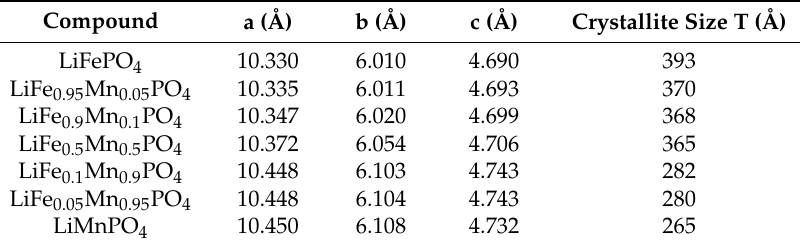
Table 3. Cell parameters and crystallite